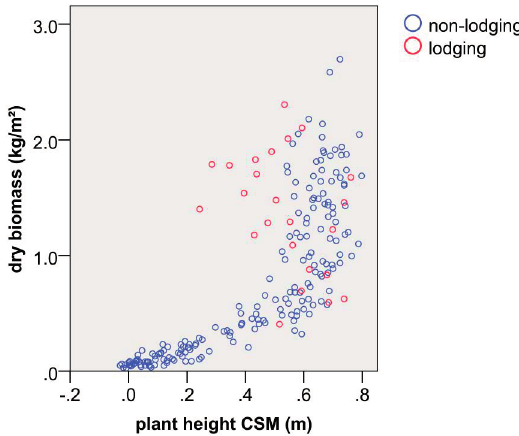
Figure 6. Scatter plot for dry biomass versus CSM n =